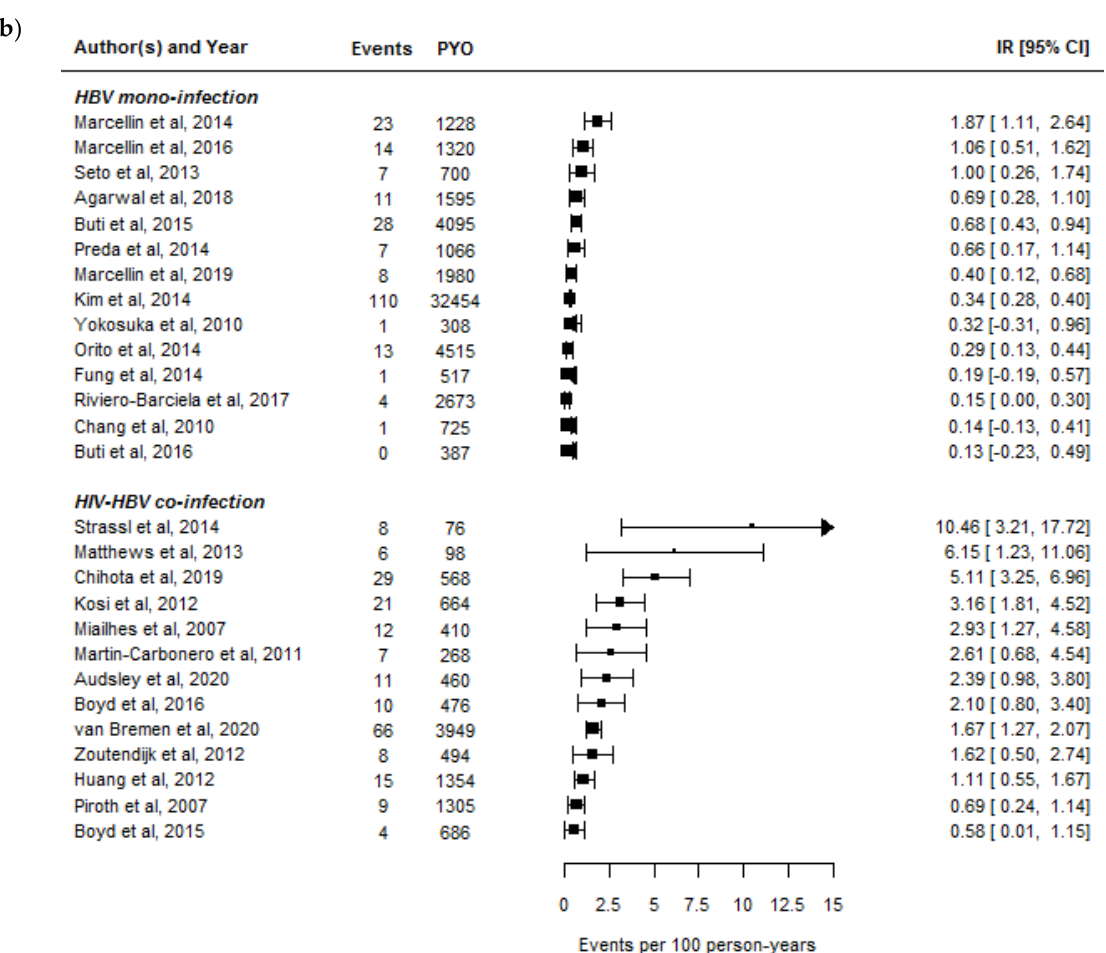
Figure 1. Summary of hepatitis B “e” antigen seroclearance ( a ) and hepatitis B surface antigen seroclearance rates ( b ) in studies of hepatitis B virus (HBV) mono-infected and human immunodeficiency virus (HIV)-HBV co-infected individuals undergoing potent anti-HBV therapy with nucleoside/nucleotide analogues. The size of the squares is proportional to the number of study participants. The selection of articles is described in Table 1. The assumptions used to derive seroclearance estimates are described in the Supplementary Methods S1.